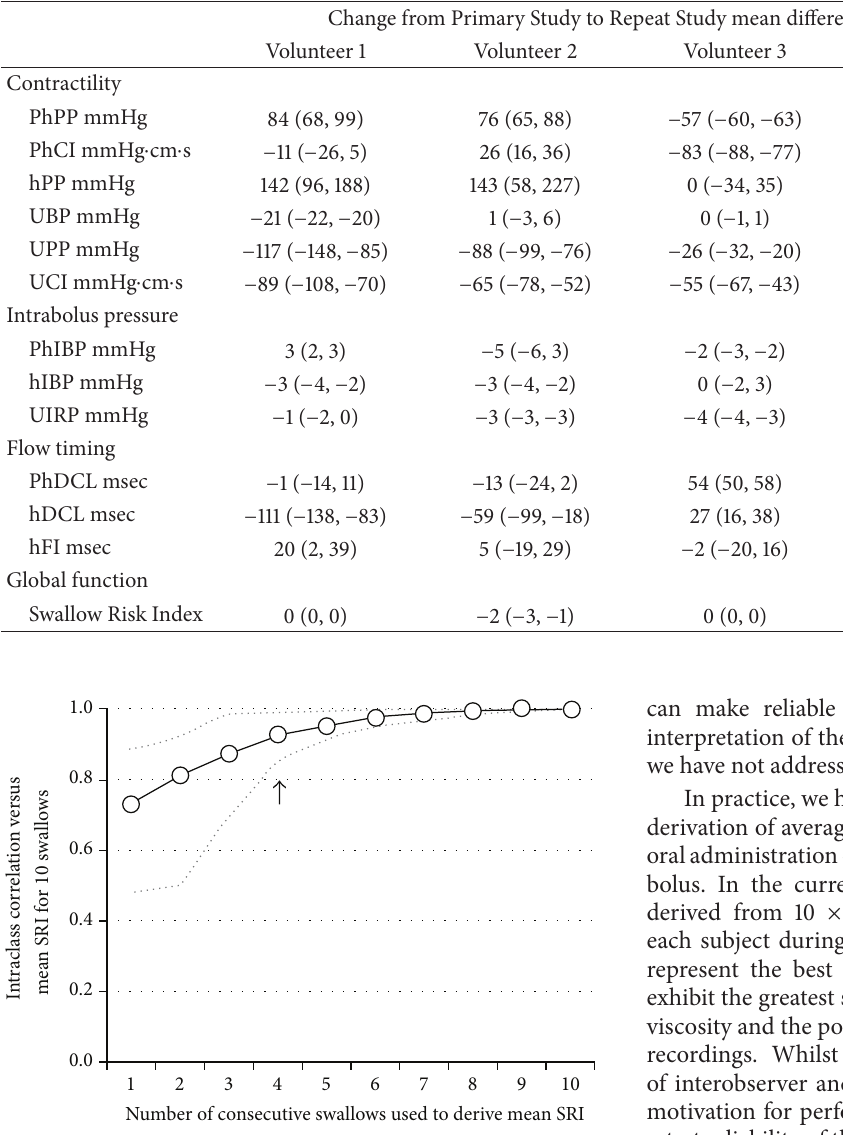
Figure 3: Intraclass correlations between the mean SRI using 1 to 10 consecutive swallows versus the all-swallow mean SRI. Data are based on 1st analysis results for Primary and Repeat Studies combined (10 measures, two per analyst). Analyst minimum and maximum ICC are grey dotted lines. Note: excellent reliability (ICC > 0.8) was found for all analyst results (i.e., when the grey dotted line representing minimum analyst ICC breaches the 0.8 threshold) when the SRI was based on the average of at least four consecutive swallows